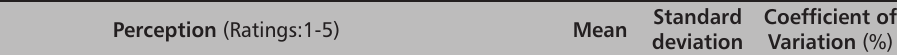
Standard Coefficient of deviation Variation